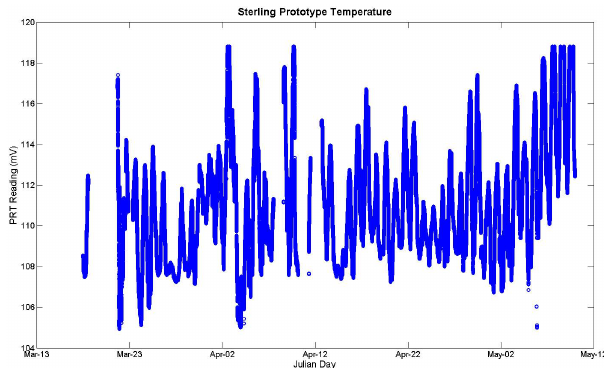
Fig. 11. Time series of platinum resistance thermometer (PRT) ob- servations in March–May 2011 from Domain 10: North Sterling, Colorado, but all of the flagged data have been removed, leav- ing only observations that passed all automated plausibility tests ( ∼ 4.1% of the raw data was